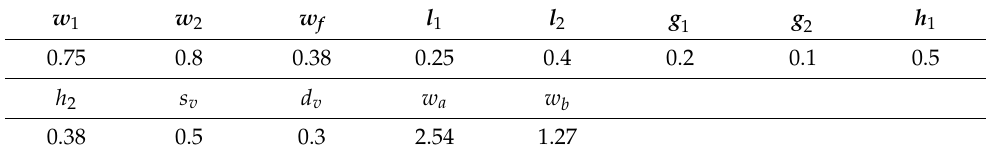
Figure 4. The simulated S-parameters of the proposed transition. Figure 3. The configuration of the proposed transition. ( a ) 3D view. ( b ) Top view. Table 1. The dimensions of the proposed microstrip to waveguide transition. (Unit: mm).